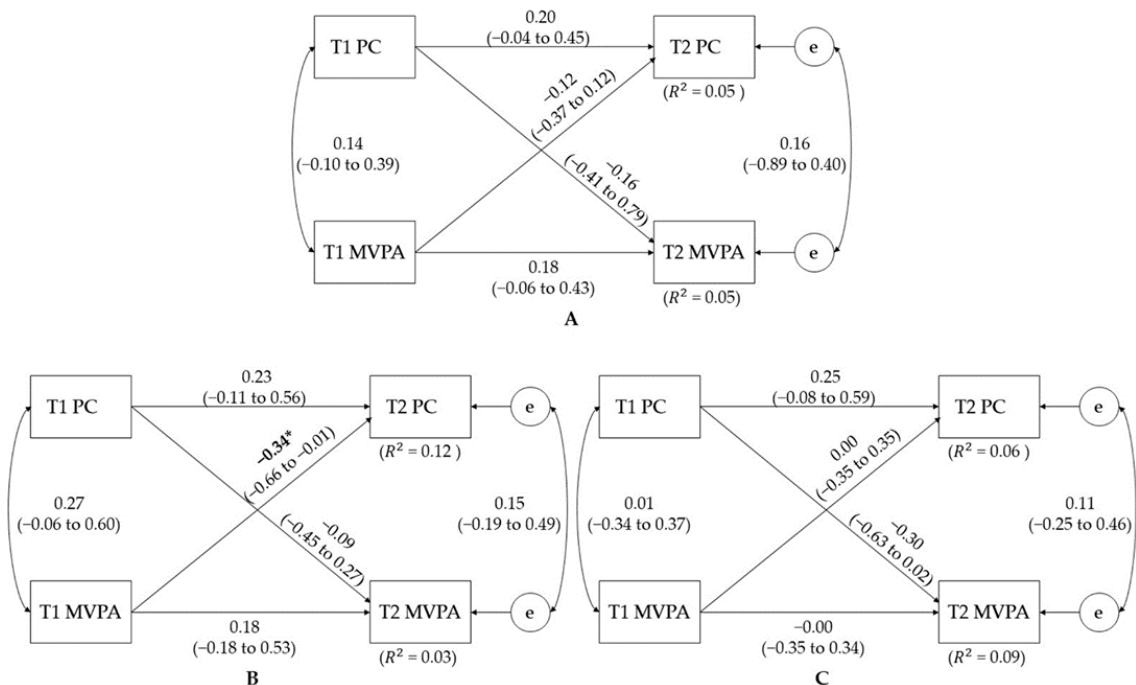
Figure 3. Cross-lagged model of the bidirectional relationships between PC and total MVPA time before and after the 8-week study period for ( A ) total, ( B ) girls, and ( C ) boys. T1—baseline time; T2—follow-up time; MVPA—moderate-to-vigorous physical activity. Path coefficients are standardized with 95% confidence intervals. * denotes a statistically significant path coefficient with p < 0.05.